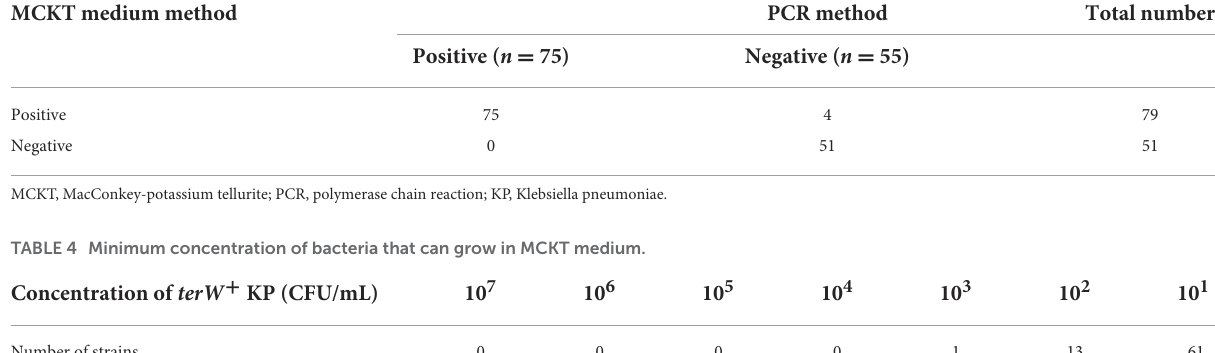
TABLE 3 Clinical performance comparison of MCKT medium and PCR in detecting terW + KP.